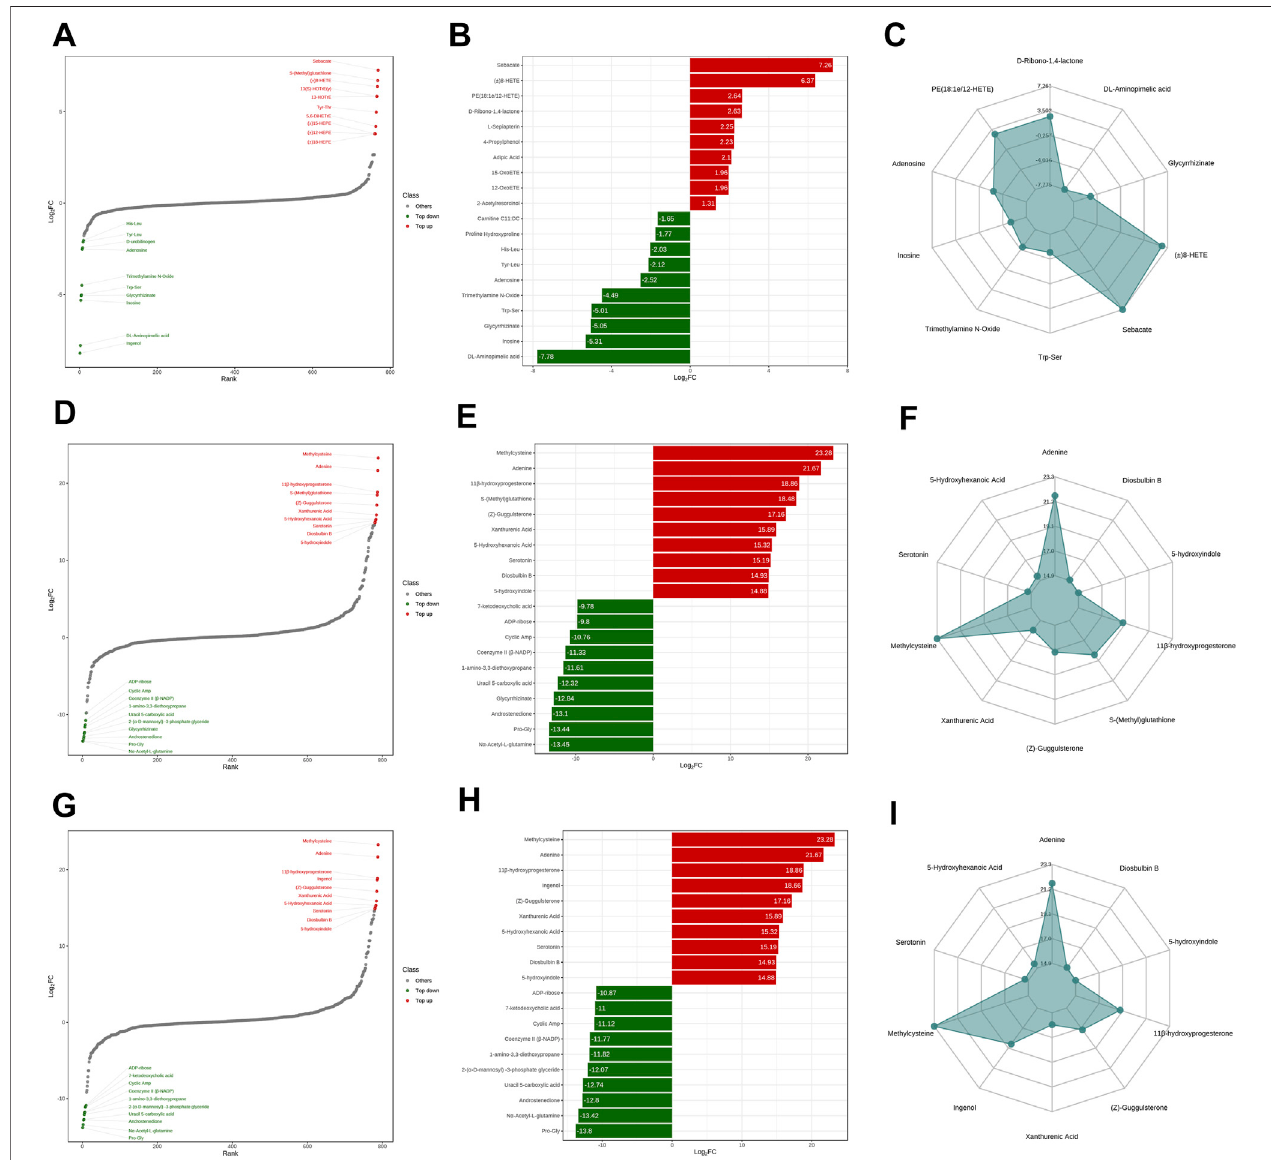
FIGURE3| Identi fi eddifferentialmetabolitescharacteristic.( (A – C) DynamicdistributionofupregulatedanddownregulatedmetabolitesbetweenZAandZB; (D – F) dynamic distribution of upregulated and downregulated metabolites between ZA and ZC; (G – I) dynamic distribution of upregulated and downregulated metabolites betweenZBandZC;10mostupregulatedmetaboliteswerewithreddots/barand10mostdownregulatedmetaboliteswerewithgreendots/bar;Radarmapselectively demonstrates 10 representative metabolites with change score).